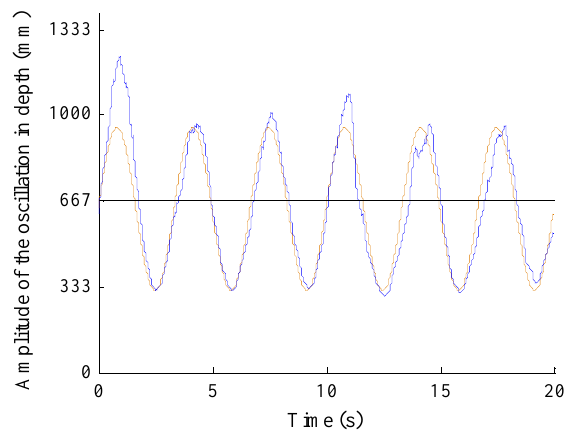
Figure 2. Example of processed vergence response as a function of time (over one slot) for one subject. Orange line: stimulus. Blue line: response.